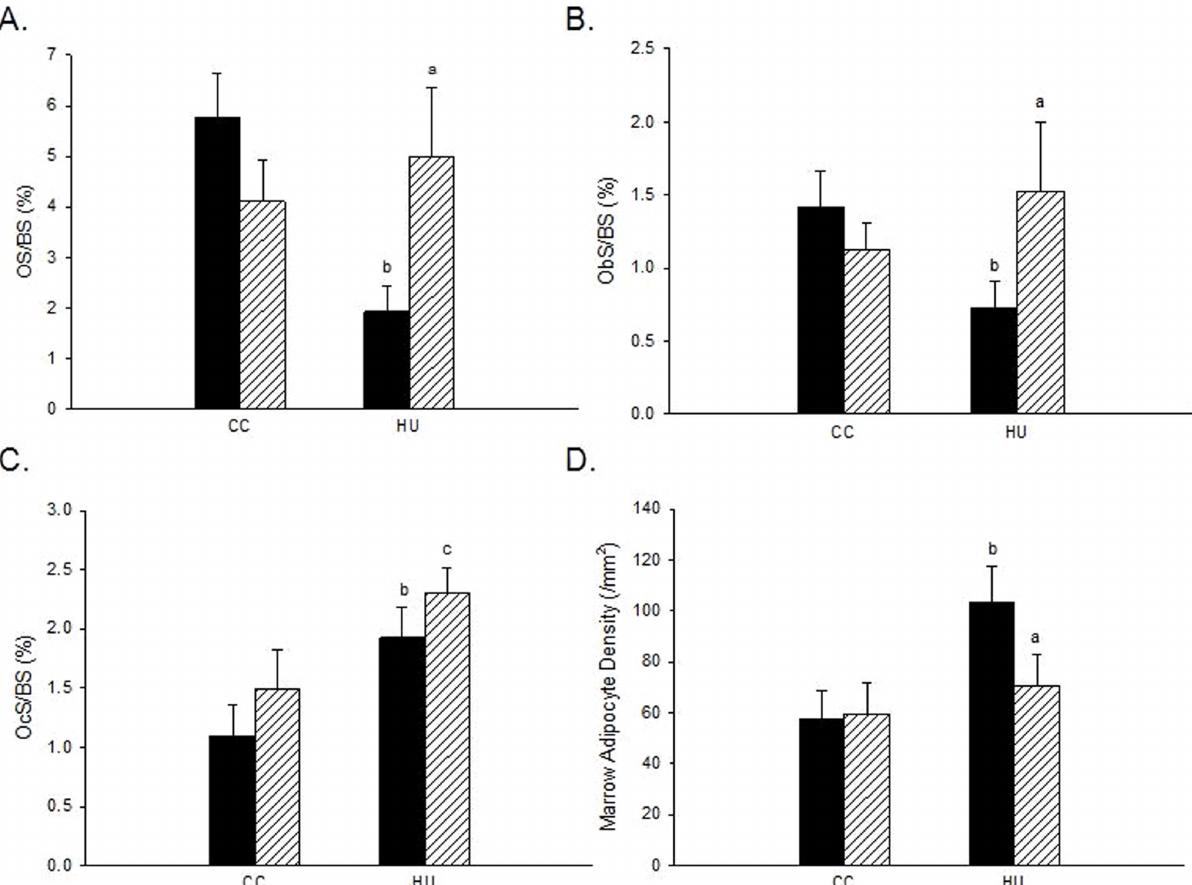
Figure 3. Effects of dobutamine (DOB) or vehicle (VEH) administration during hindlimb unloading (HU) or ambulatory cage activity (CC) on cancellous bone measures of histomorphometry. A : Osteoid Surface (OS/BS). B : Osteoblast Surface (ObS/BS). C : Osteoclast Surface (OcS/BS). D : Adipocyte Density (N.Ad/Ma.Ar). VEH groups are represented by black bars; DOB groups are represented by striped bars. a HU + DOB vs. HU + VEH (p # 0.05); b HU + VEH vs. CC + VEH (p # 0.05); c HU + DOB vs. CC + DOB (p #